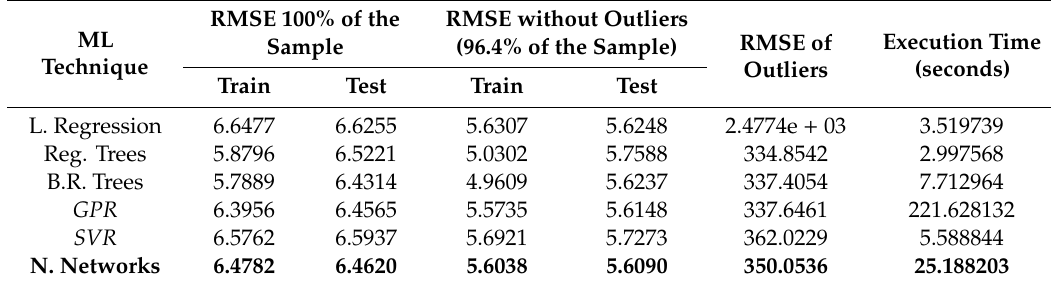
Table 4. BMI-CTDI VOL results for men’s Skull protocol.